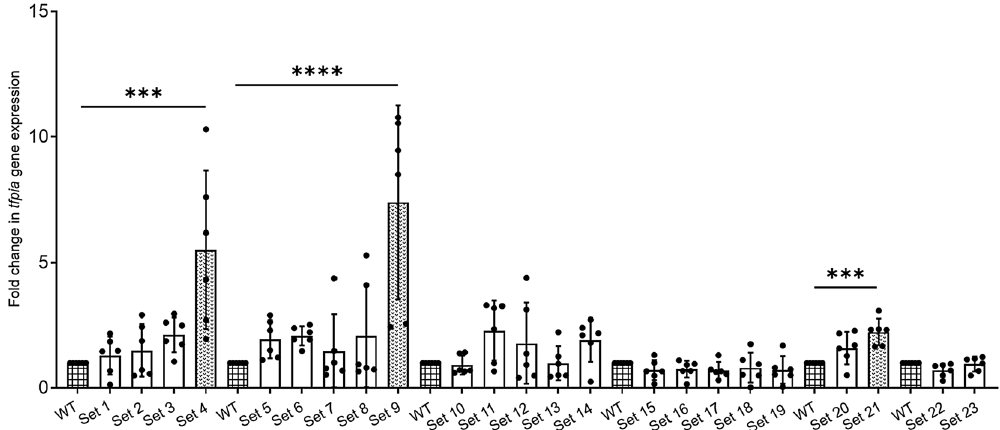
Figure 1. Levels of tfpia mRNA in a primary knockdown screen of chromatin binding and regulatory proteins. Quantitative real-time PCR showing the fold change of tfpia gene expression in liver and spleen in 23 sets (Set 1–Set 23) of chromatin binding and regulatory protein-knockdowns compared to daily wild-type (WT) controls using one-way ANOVA. The bar graphs represent daily wild-type controls (squared bars), and all knockdowns (open bars and dotted bars) to the right of each wild-type were performed on the same day. Error bars represent mean ± SD. Six fish were used for each set of chromatin binding and regulatory protein-knockdown and control experiments (N = 6). The lines on the top represent a significant difference between wild-type and knockdown sample sets. *** and **** represent p ≤ 0.001 and p ≤ 0.0001, respectively. p-value < 0.05 was considered significant.